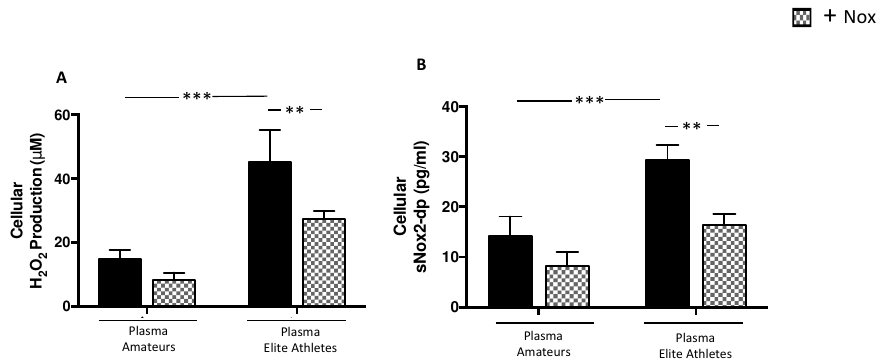
Figure 5. Oxidative stress in supernatants of HSMM-plasma co-cultures. H 2 O 2 levels ( A ), and sNOX2dp concentration ( B ) were evaluated in supernatants of HSMM (Human Skeletal Muscle Myoblast) cell cultures treated with plasmas taken from amateurs (n = 3) and elite athletes (n = 3) in the presence or not of NOX2ds-tat. (n = 3) (Data are represented as mean ± standard deviation) (*** p < 0.001, ** p < 0.01).